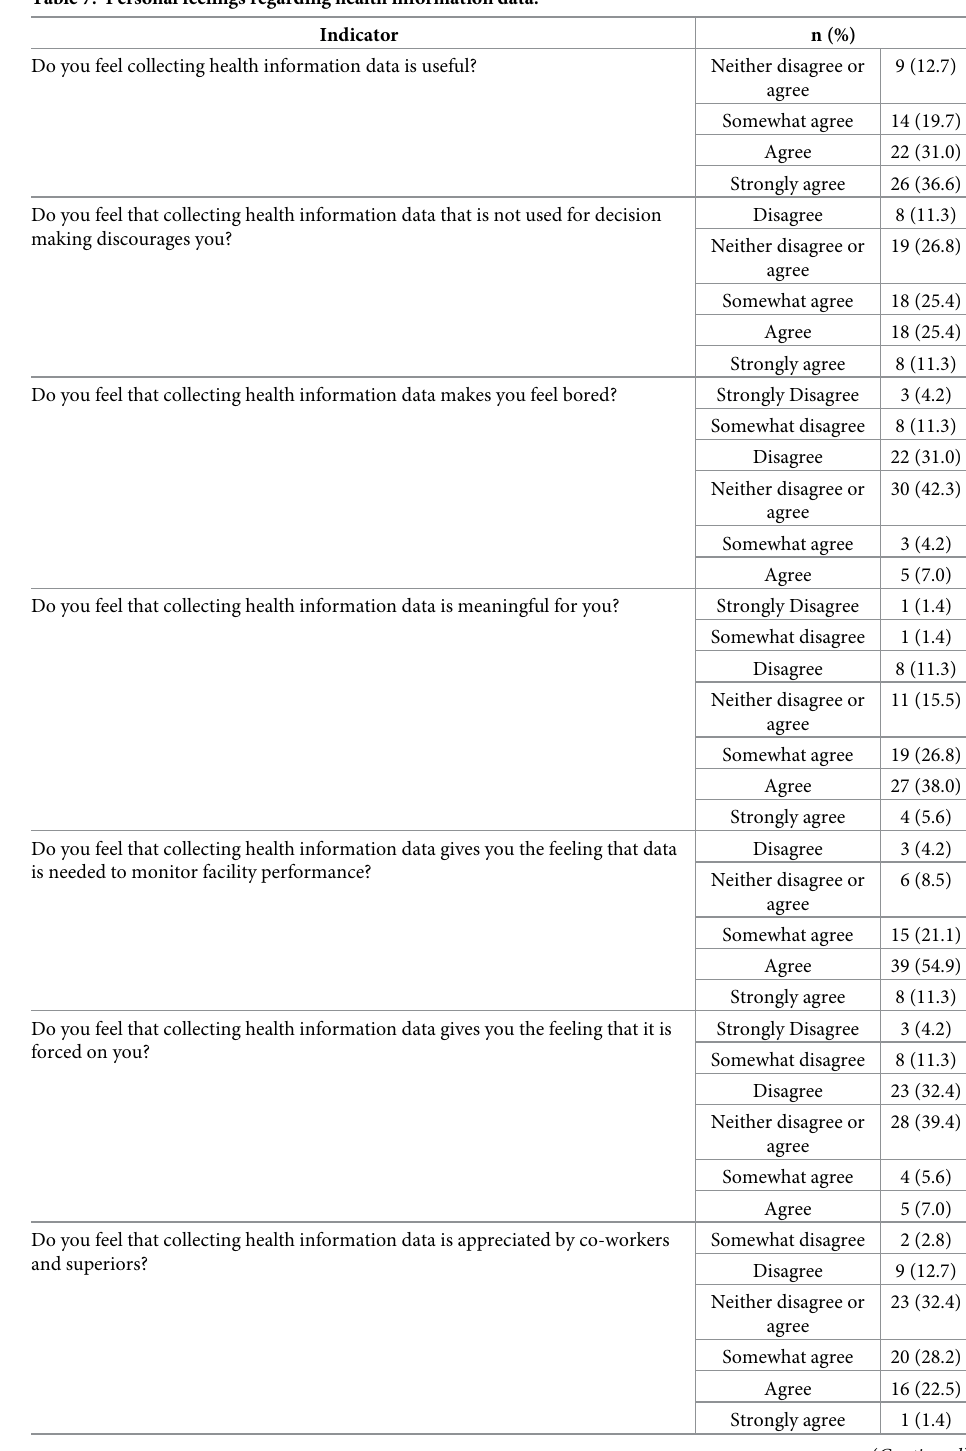
Table 7. Personal feelings regarding health information